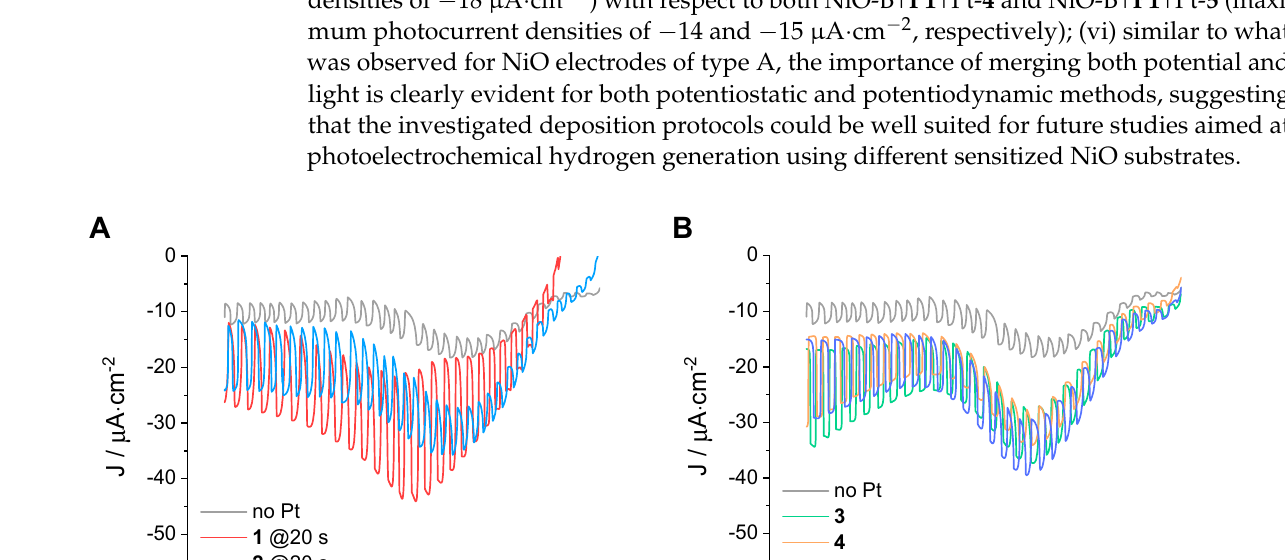
Figure S2. LSV of sensitized NiO electrode of type B in N 2 -purged 0.1 M acetate buffer at pH 4 in the presence of 0.01 M [Co(NH 3 ) 5 Cl]Cl 2 as an irreversible electron acceptor. Figure S3. Film thickness electron acceptor. Figure S3. Film thickness of NiO electrodes of type A and type B measured using of NiO electrodes of type A and type B measured using profilometry. Figure S4. Section analyses of profilometry. Figure S4. Section analyses of NiO electrodes of type A and type B measured using AFM. Figure S5. Absorption spectrum of a solution (optical pathlength of 1 cm) obtained after desorption of a sensitized NiO electrode of type A (average of three samples, surface area of 1.5 cm 2 ) with 20 µ L TBAOH 1 M in methanol and further dilution with methanol to a total volume of 3 mL. Figure S6. Absorption spectrum (average of three samples) of a NiO electrode of type B sensitized after overnight soaking in a 0.5 mM acetonitrile solution of the P1 dye. Figure S7.